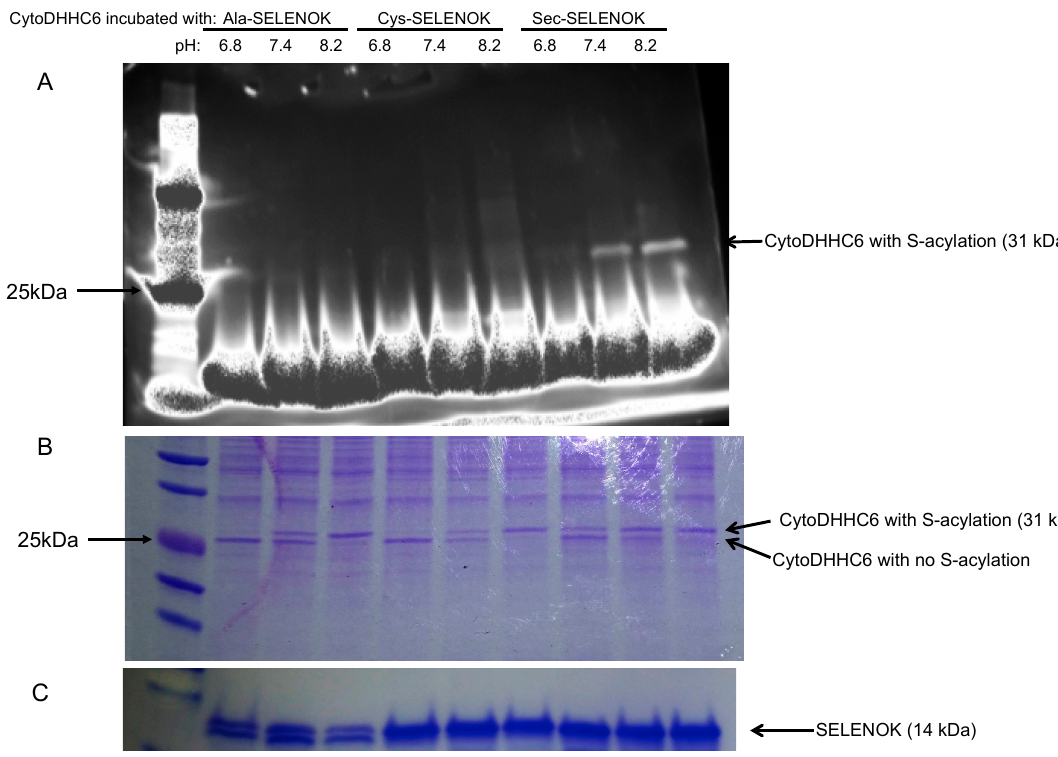
Figure 4. Sec-containing SELENOK stabilizes acyl-DHHC6 intermediate formed during the autopalmitoylation of the enzyme. Cytosolic DHHC6 bound to different versions of SELENOK (U92 → A, U92 → C, and U92) bound to StrepTactin beads were incubated for 60 min with fluorescent NBD-palmitoyl-CoA in buffer of pH 6.8, 7.4, and 8.2. Beads were then washed, proteins eluted and analyzed by SDS-PAGE. ( A ) The gel was exposed to uv using a transilluminator and the acylated DHHC6 visualized at ~31 kDa with highest levels found in the lanes corresponding to Sec-containing SELENOK at pH 7.4 and 8.2. ( B ) Coomassie Blue staining of the gel revealed two bands for DHHC6 ~31 kDa. Based on the pattern within the pH ranges, the upper band corresponds to acylated DHHC6 and the lower band to the nonacylated DHHC6. ( C ) Coomassie Blue staining of the gel in the region of SELENOK (~14 kDa) shows that the protein was eluted from beads at equivalent levels. Note that some degradation of the recombinant SELENOK occurred during the overnight incubation giving rise to double bands.